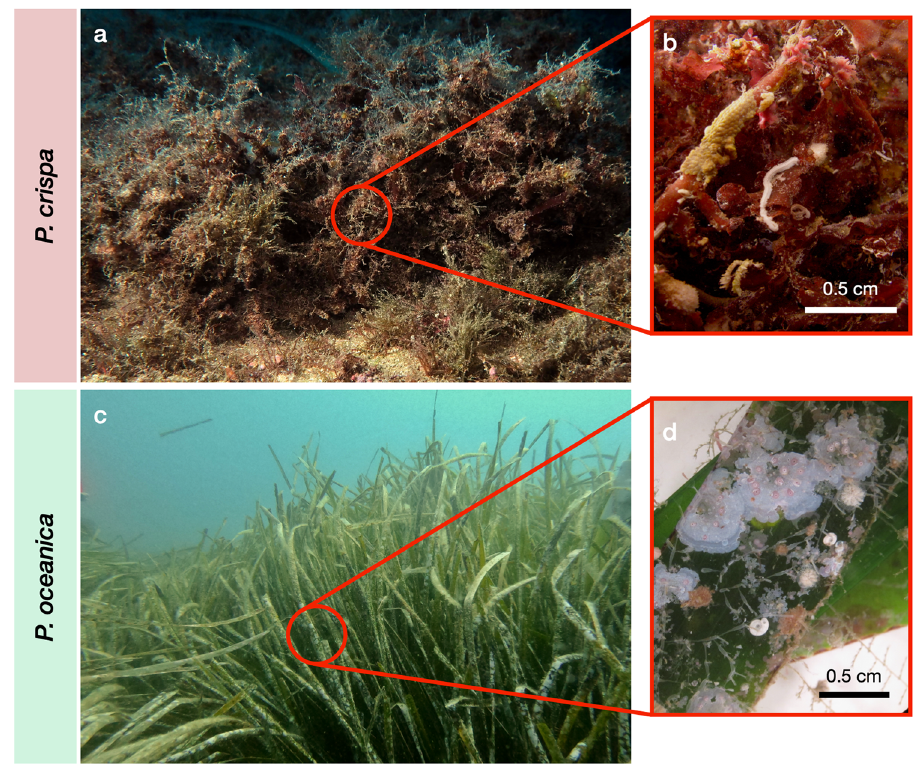
Fig. 1 Phyllophora crispa mat and Posidonia oceanica seagrass meadow with associated sessile invertebrates. P. crispa mat ( a ) and P. oceanica meadow ( c ) with Bryozoa, Polychaeta and Foraminifera on P. crispa thalli ( b ), Bryozoa, Polychaeta and crustose coralline algae (Corallinales) as epiphytes on P. oceanica leaves ( d ). Pictures taken by Felix I. Rossbach ( a , b , d ) and Friederike Peiffer ( c ).